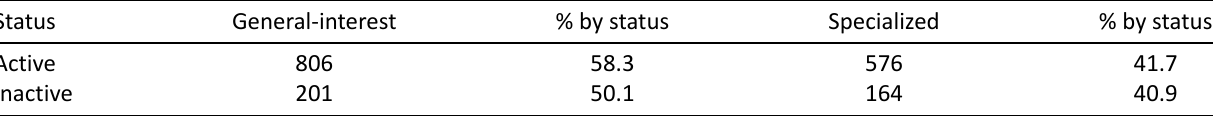
Table 4. General-interest and specialized digital-native news media (N = 1,382, November 2019).